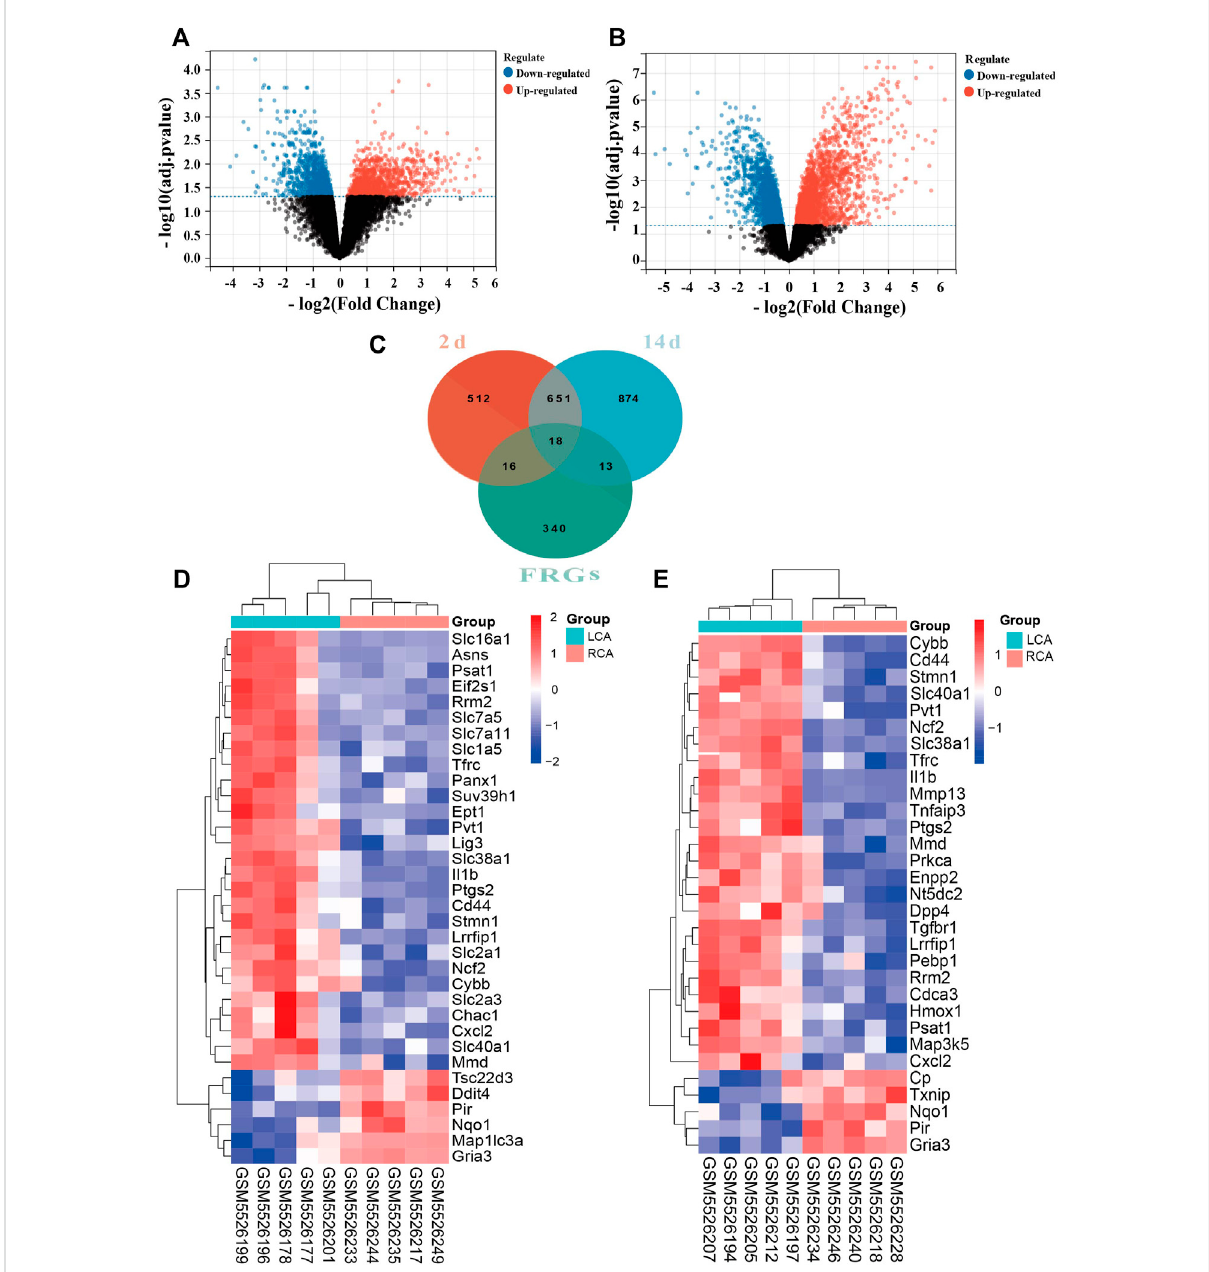
FIGURE 2 Differentiallyexpressedferroptosis-relatedgenes(FRGs)inearlyandlateintimalhyperplasia(IH). (A) Thevolcanoplotofdifferentiallyexpressed genes 2 days after ligation. (B) The volcano plot of differentially expressed genes 14 days after ligation. The abscissa represents the difference in the fold change of gene expression in different treatment groups, and the ordinate represents the adj. p -value of the expression difference. Blank dots represent unchanged genes. Red dots represent upregulated genes, and blue dots represent downregulated genes. (C) The overlapping genes between FRGs and DEGs 2 and 14 days after ligation. (D) The heatmap of differentially expressed FRGs in the carotid artery samples 2 days after ligationbasedontheclusteringanalysis. (E) TheheatmapofdifferentiallyexpressedFRGsinthecarotidarterysamples14 daysafterligationbasedon the clustering